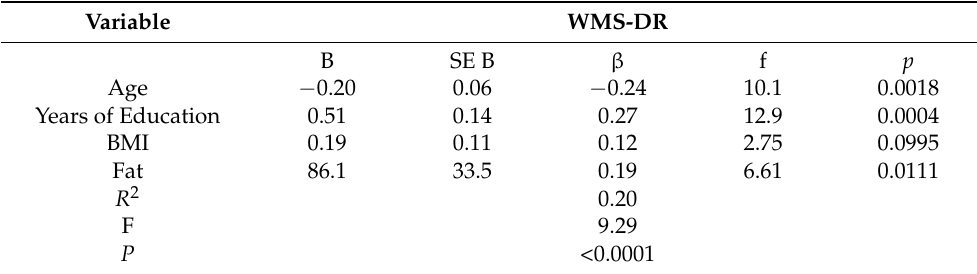
Table 5. Association between Wechsler Memory Scale-Delayed Recall (WMS-DR) score and con- sumption of fat.